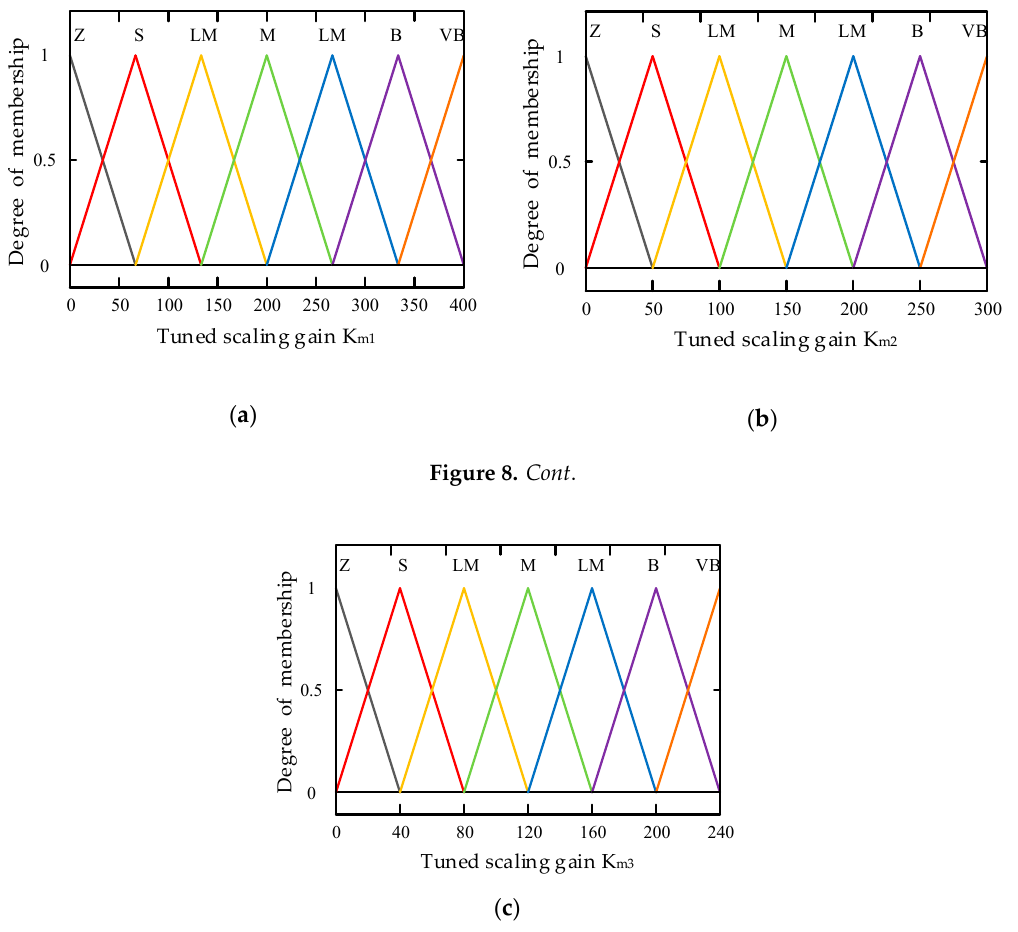
Figure 7. Membership function of the load torque variation: ( a ) T load_ 1 , ( b ) T load_ 2 , ( c ) T load_ 3 .